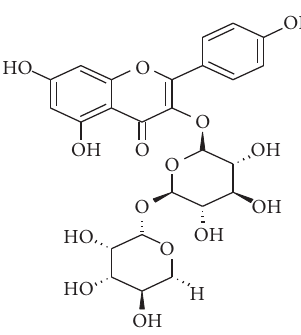
Figure 3: Chemical structure of rutin